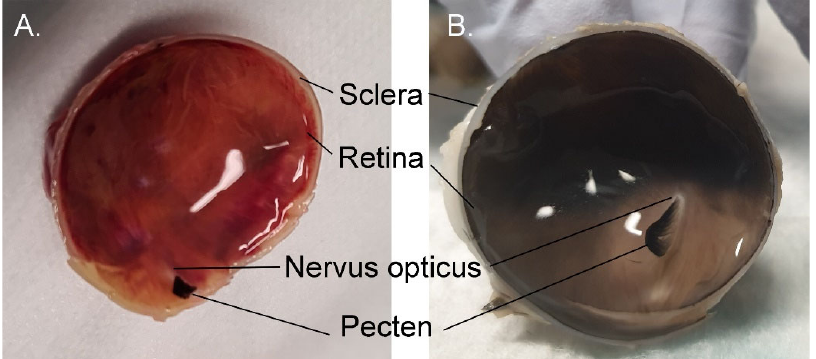
Figure 10. The colour of the fundus is predominantly a product of the choroid. No intrinsic retinal vasculature is present. ( A ) King penguin Aptenodytes patagonicus ; ( B ) Gentoo penguin Pygoscelis papua . The king penguin has a pink fundus but that of the gentoo has a mostly dark brown colouration, with the exception of the inferior third. Credit: PWH.